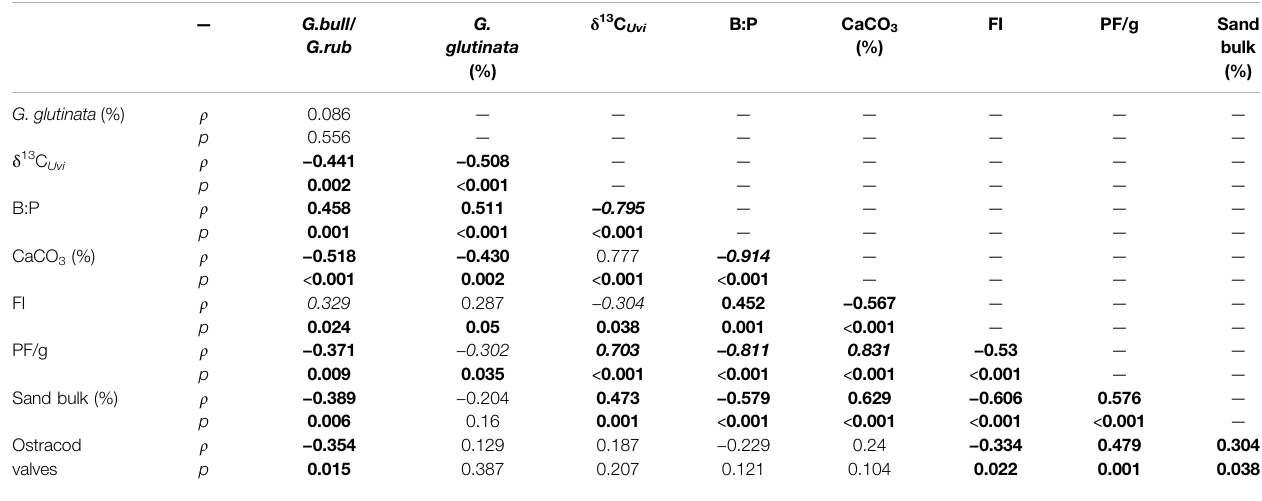
TABLE 1 | Correlation coef fi cient ( ρ ) and statistical signi fi cance ( p ) for productivity and dissolution indices in sediment core SAT-048A from the western South Atlantic. G. glutinata (%): Relative abundance of Globigerinita glutinata ; δ 13 C Uvi : VPDB δ 13 C-values of shells of the benthic foraminifer genus Uvigerina ; B:P: Ratio between benthic and planktonic Foraminifera; CaCO 3 (%): Relative CaCO 3 content of the sediment; FI: Planktonic foraminifera fragmentation intensity; PF/g: Number of Planktonic foraminiferal tests per gram of sediment; bulk sand (%): Relative sand content of the sediment; Ostracod valves: Number of Ostracod valves per Gram of sediment. Signi fi cant p -values (at α = 0.05) are highlighted in bold; for these, the correlation coef fi cient was marked as weak (italics), medium (bold), or strong